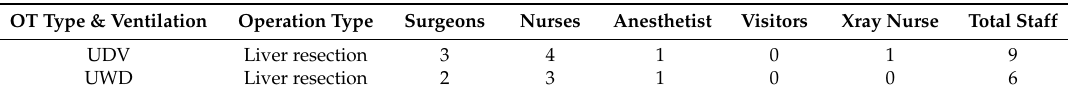
Table 2. Composition of the medical staff during six liver resection operations (A to F) in different OT types and ventilation